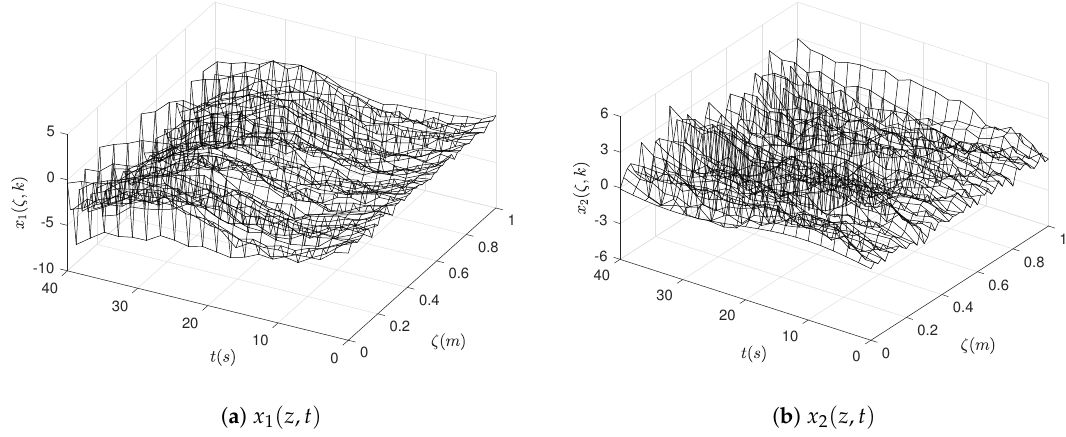
Figure 10. State evolution of the noisy wave